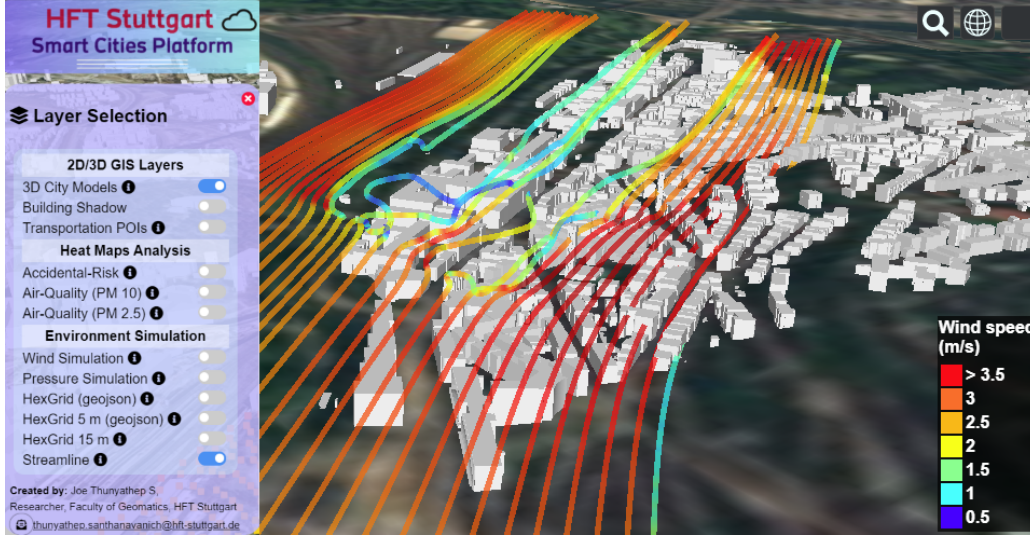
Figure 10. Screenshot of the Smart City Platform as the resulting web-application. In this web-based application, the user can chose different visualization schemes to view CFD results. The platform can be accessed using the following link: